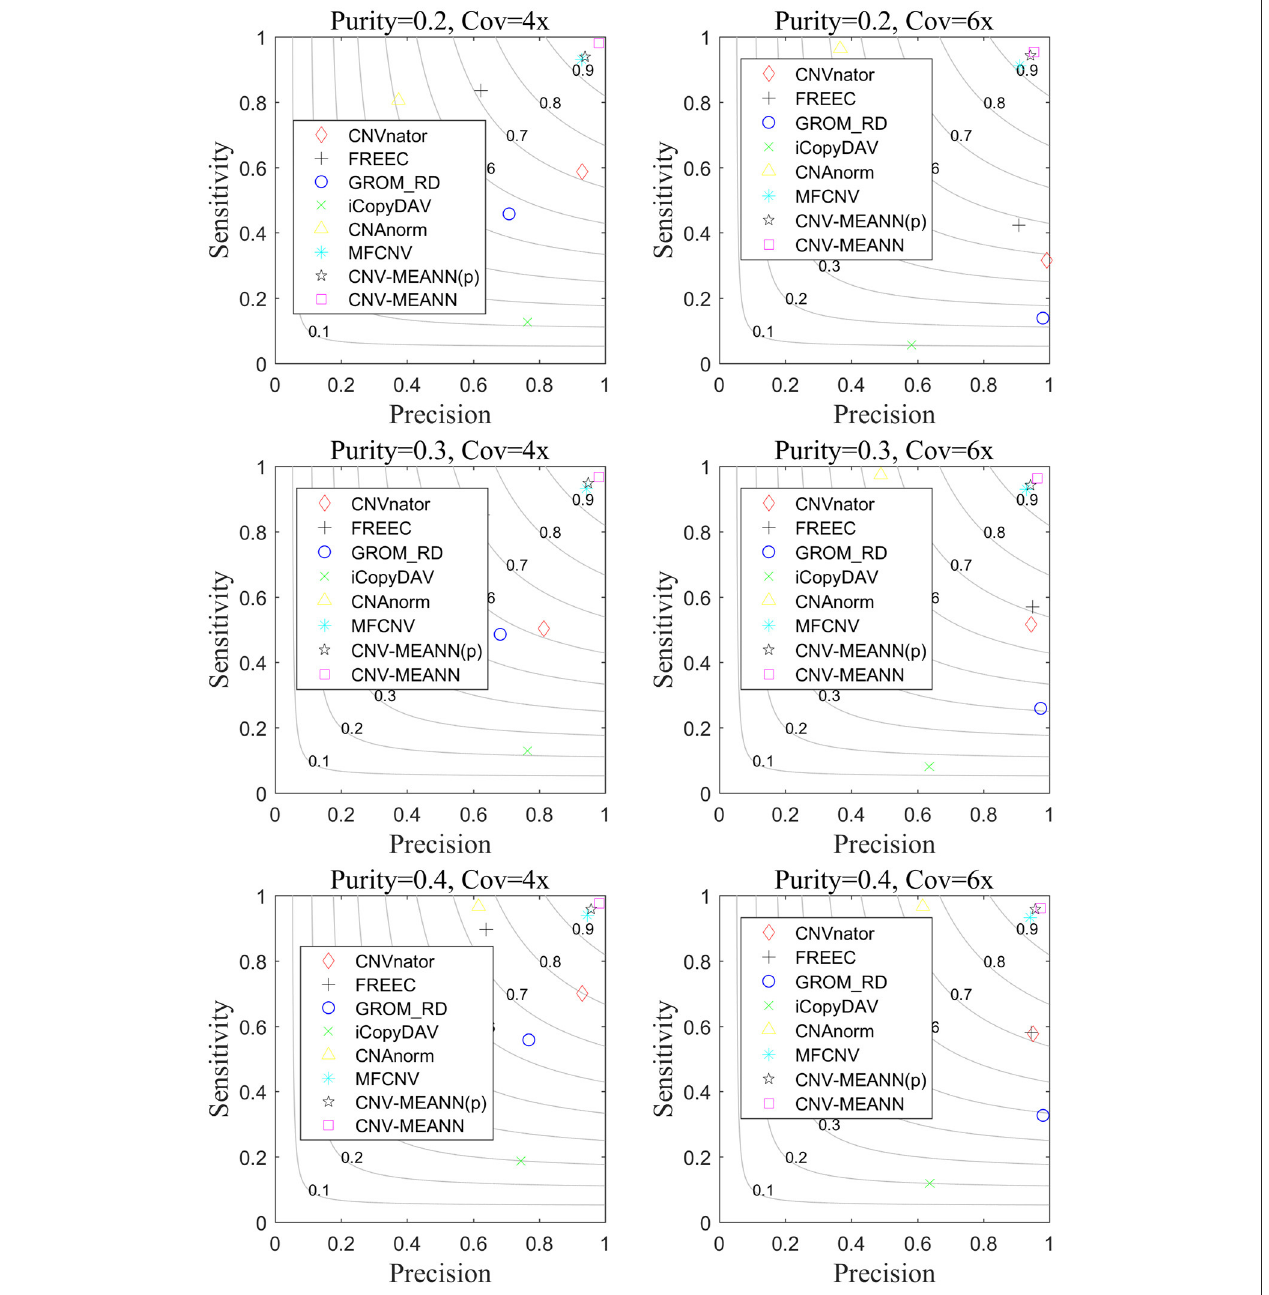
FIGURE 5 | The performance comparison of the CNV-MEANN method and the eight same methods in the aspects of sensitivity, precision and F1-score on simulation datasets under six